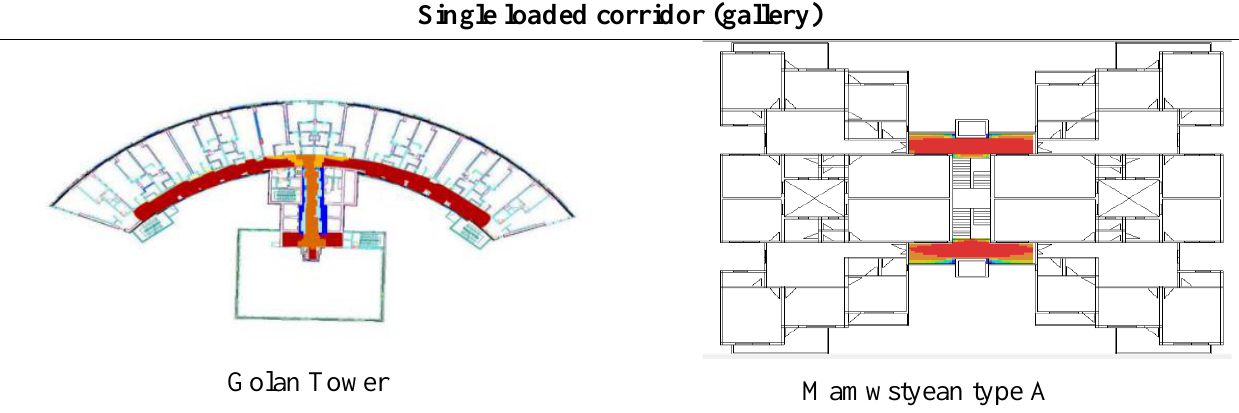
Figure 3. Graphs of visual connectivity analysis for ten cases study plan The examination of the color map of the visibility graph indicates that the highest degree of visual connectivity is represented in a red color concentrated around the apartment's corridor, as shown in figure 3. The spaces with the lowest visual access are illustrated in a blue color located around the corridor. The single-loaded corridor layout design graphs showed that the corridor area has the most visual connectivity than the other types. At the same time, the layout design graph of each mixed and point type showed that the corridor space areas have low visual connectivity. The result suggested that the single-loaded corridor apartment layout design is more functionality than the other types. However, the design type of Double loaded corridor affects increasing the functionality of apartment